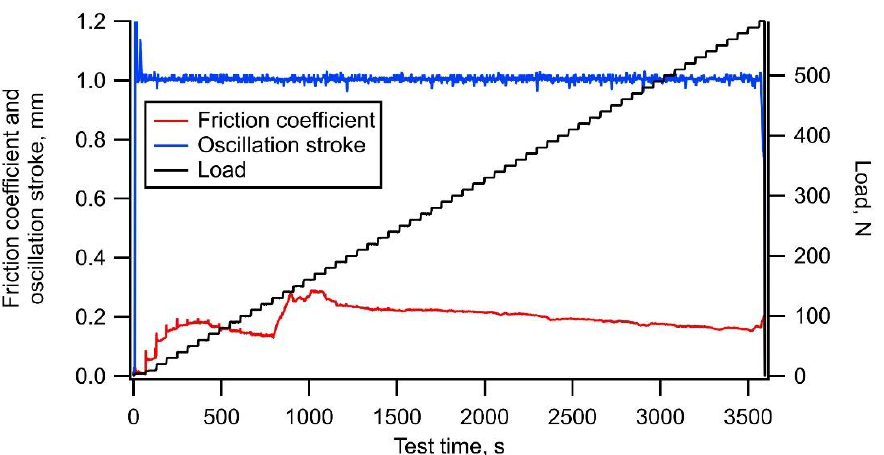
Figure 3. Typical example of trends of friction coefficient, oscillation stroke, and load during test using a-C film.